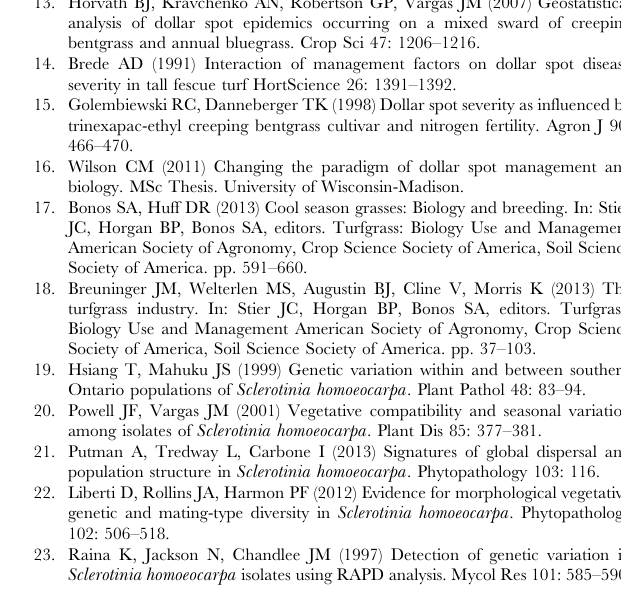
File S1 DNA sequences from overwintering Sclerotinia homoeocarpa isolates, isolate ‘Shark’ obtained from commercial seed, and S. homoeocarpa EF1 a sequences from seed lots positive by nested